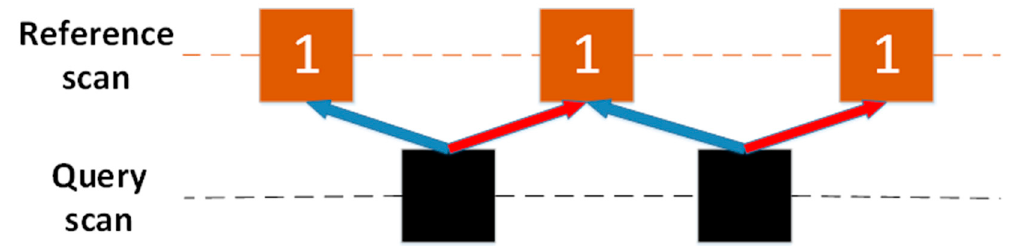
Figure 6. The original CSM matching diagram. In the reference scan, the number of blocks represents the occupation probability of the target. The original CSM will obtain two kinds of matching relations. The blue arrow indicates the first matching relationship, and the red arrow indicates the second matching relationship.